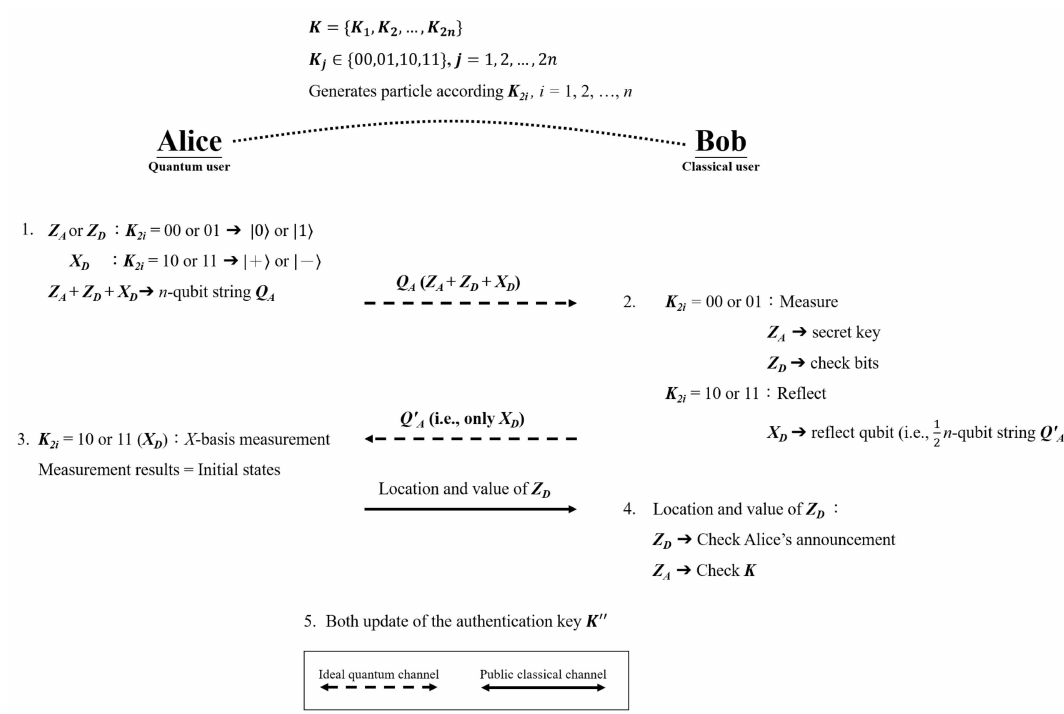
Figure 1. Zhou et al.’s measure-resend SQA protocol.